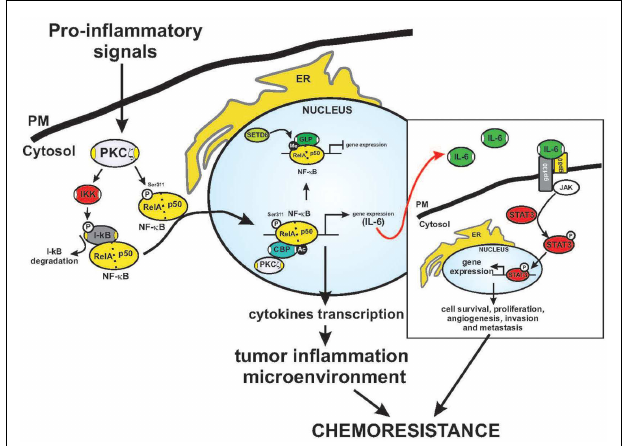
FIGURE 2 | Fine regulation of NF- κ B activation by PKC ζ . Schematic model of the regulation of PKC ζ in the inflammatory response and chromatin remodeling. Activated PKC ζ may activate IKK kinase and trigger I κ B degradation.This event precedes NF- κ B activation and